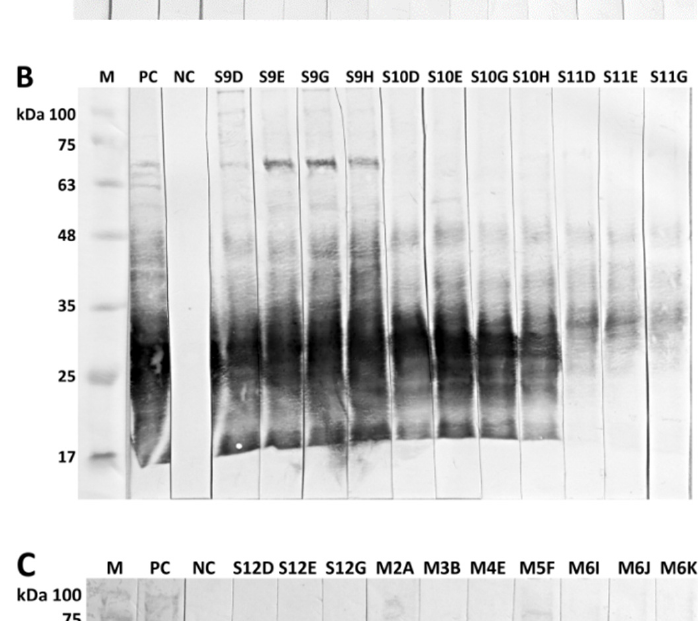
December 2021; M = marker (kDa = kilo Dalton), PC = positive control, NC = negative control.